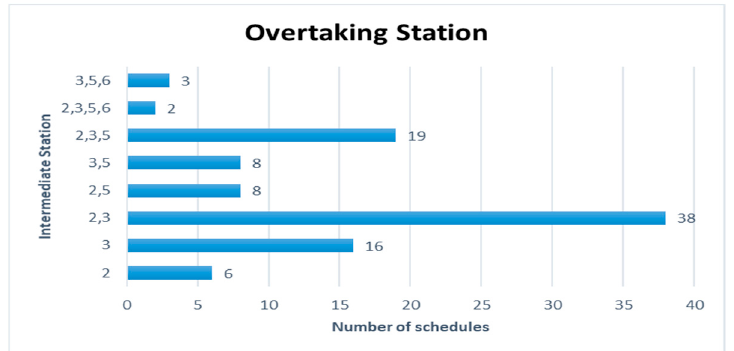
Figure 11. Frequency of Overtaking Station for Case 2.